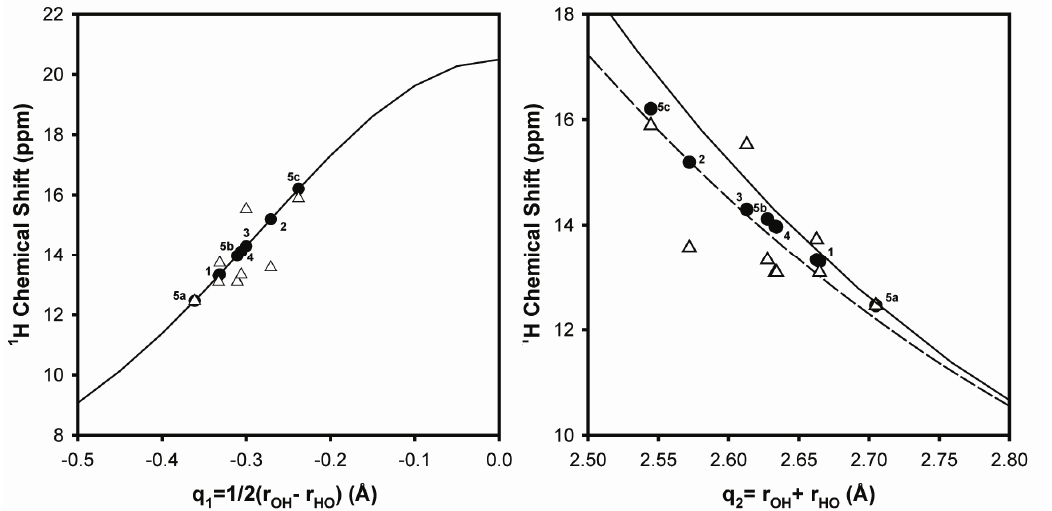
Figure 2. 1 H NMR chemical shift correlations for both the q coordinates. Chemical shifts obtained using either Equation 2 ( ● ) or with Gaussian